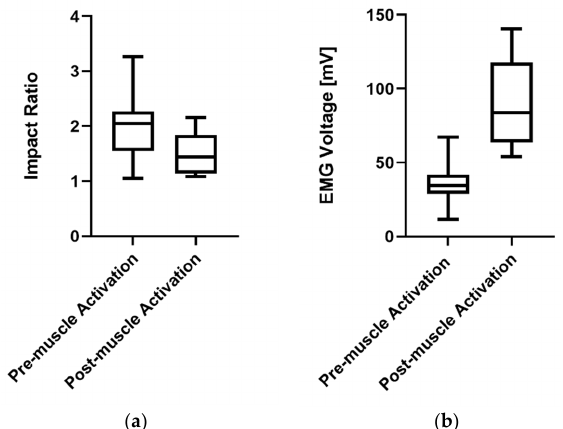
Figure 11. ( a ) Impact ratio measured by the IMU sensors; and, ( b ) voltage measured by EMG upon header impact, before and after the participant was told to tighten neck